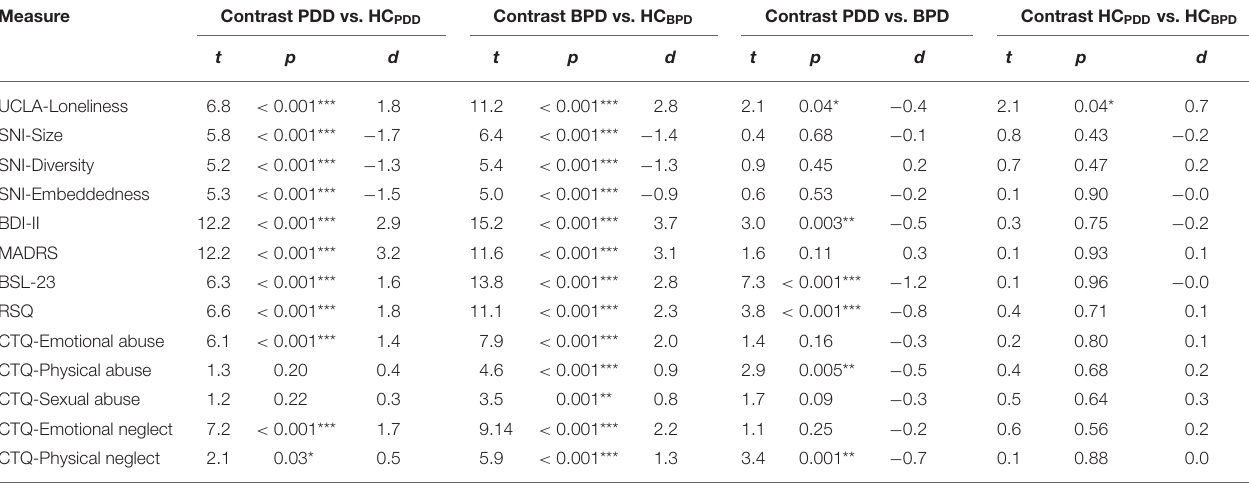
TABLE 2 | Loneliness, social network characteristics, clinical symptoms, and childhood maltreatment: results and effect size (Cohen’s d ) of planned contrasts between patient groups and their matched healthy controls. Measure Contrast PDD vs. HC PDD Contrast BPD vs. HC BPD Contrast PDD vs. BPD Contrast HC PDD vs. HC